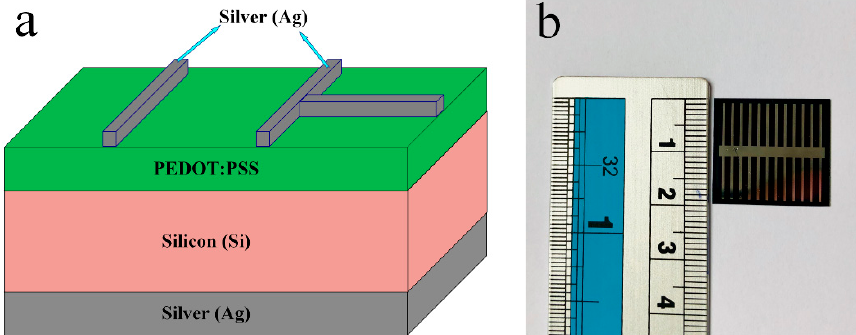
Figure 1. ( a ) The device configuration of the n-Si/poly (3,4-ethylenedioxythiophene): poly(styrenesulfonate) (n-Si/PEDOT: PSS) hybrid solar cell; ( b ) an image of the actual hybrid solar cell. Table 1. The photovoltaic parameters of the n-Si/poly (3,4-ethylenedioxythiophene): poly(styrenesulfonate) (n-Si/PEDOT: PSS) hybrid solar cell with a different thickness of PEDOT: PSS and concentration of the solvent EG.